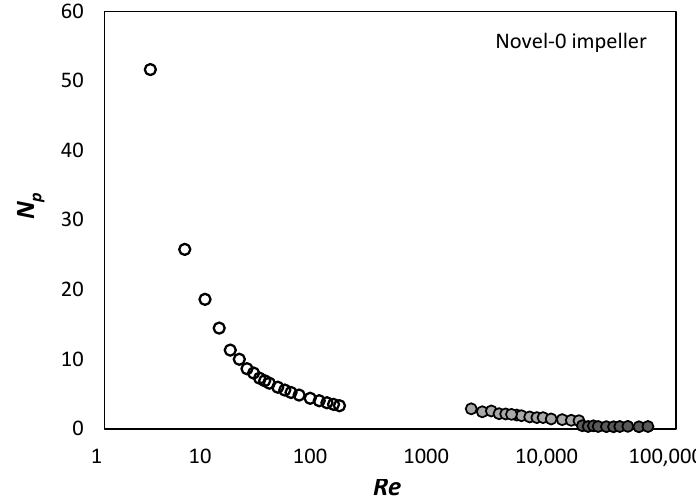
Figure 14. The power number N p evaluated from experimental measurements as a function of the Reynolds number for the Novel-0 impeller.